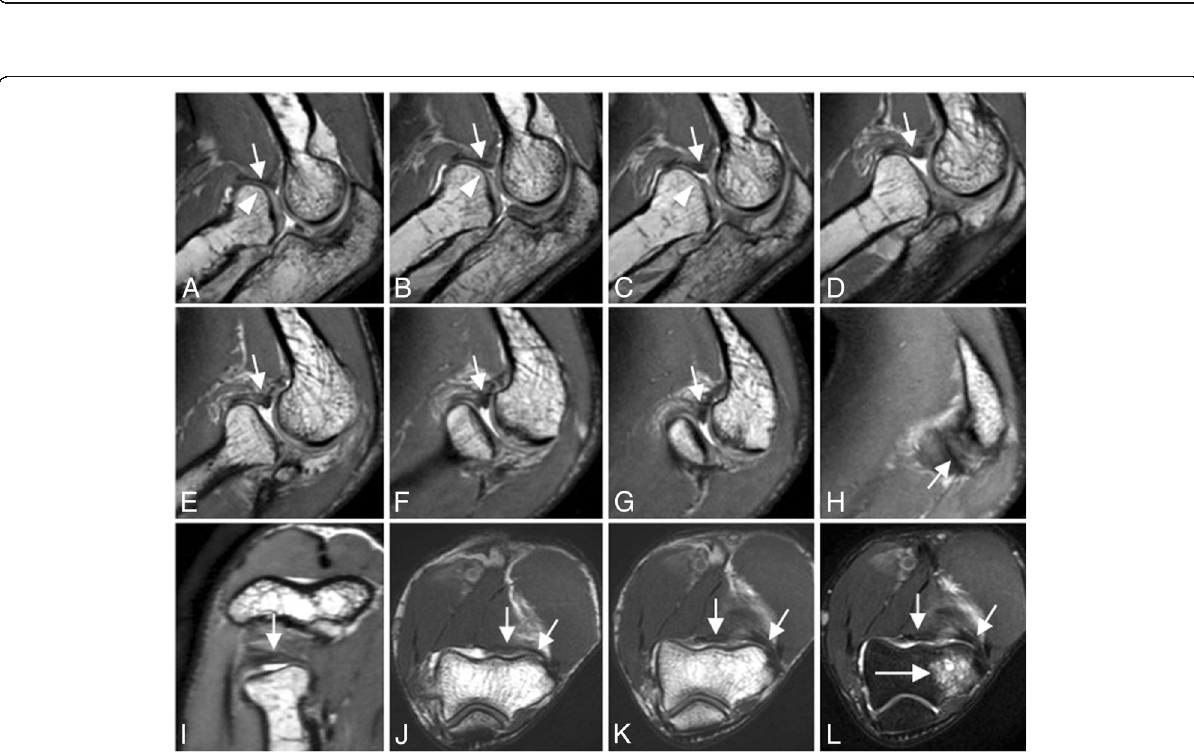
Fig. 2 A 46-year-old man with recurrent painful click in the elbow. Consecutive sagittal 3D-FSE PD-weighted MRI ( a to h ), consecutive axial 3D- FSE PD-weighted ( i to k ), and axial FS PD-weighted MRI ( l ) show superior displacement of annular ligament interposing between the radial head and the capitellum (white short arrows). Radial head deformity (white arrowheads). Capitellar osteochondral lesion (long white